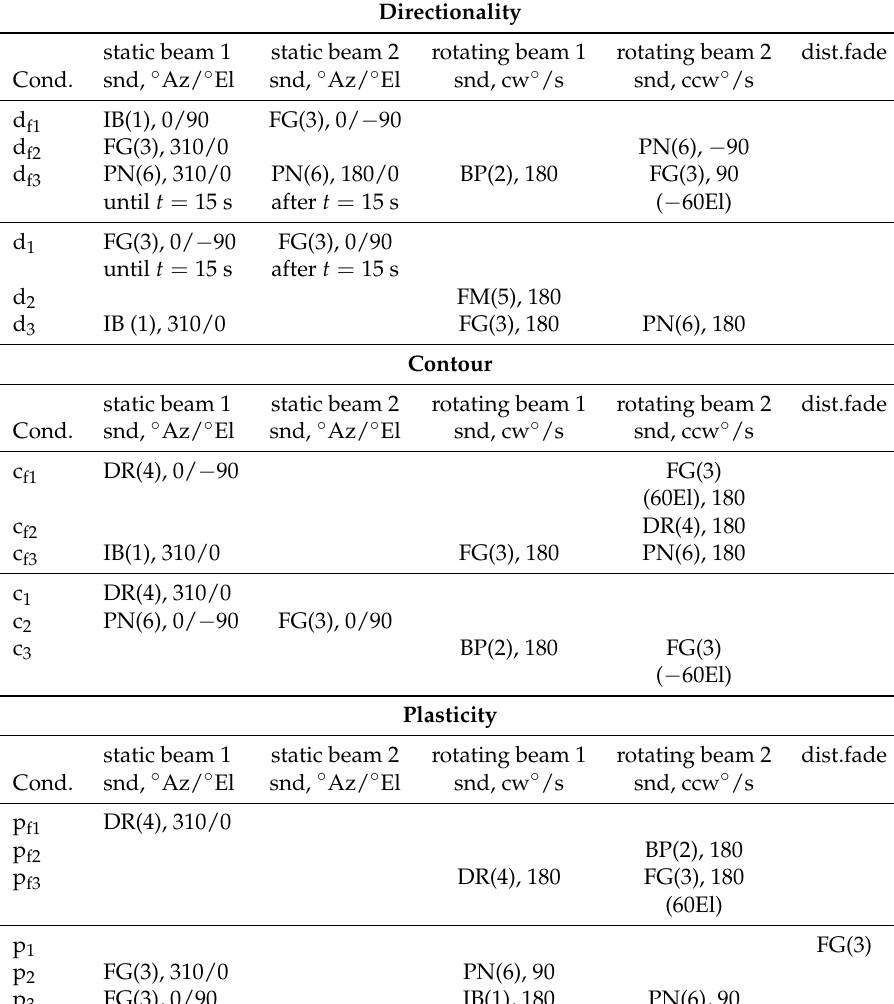
Table 1. Description of the conditions ( f ...playback during familiarization only) of experiment 1, their sound material (as described in Section 2.1), and beam direction/rotation parameters. All